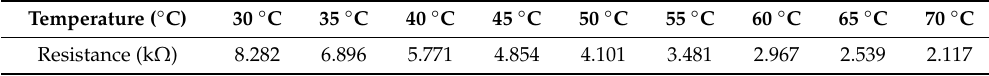
Figure 9. Temperature feedback circuit: ( a ) of leading leg, ( b ) of lagging leg. Table 1. Resistance versus temperature of negative temperature coefficient(NTC).